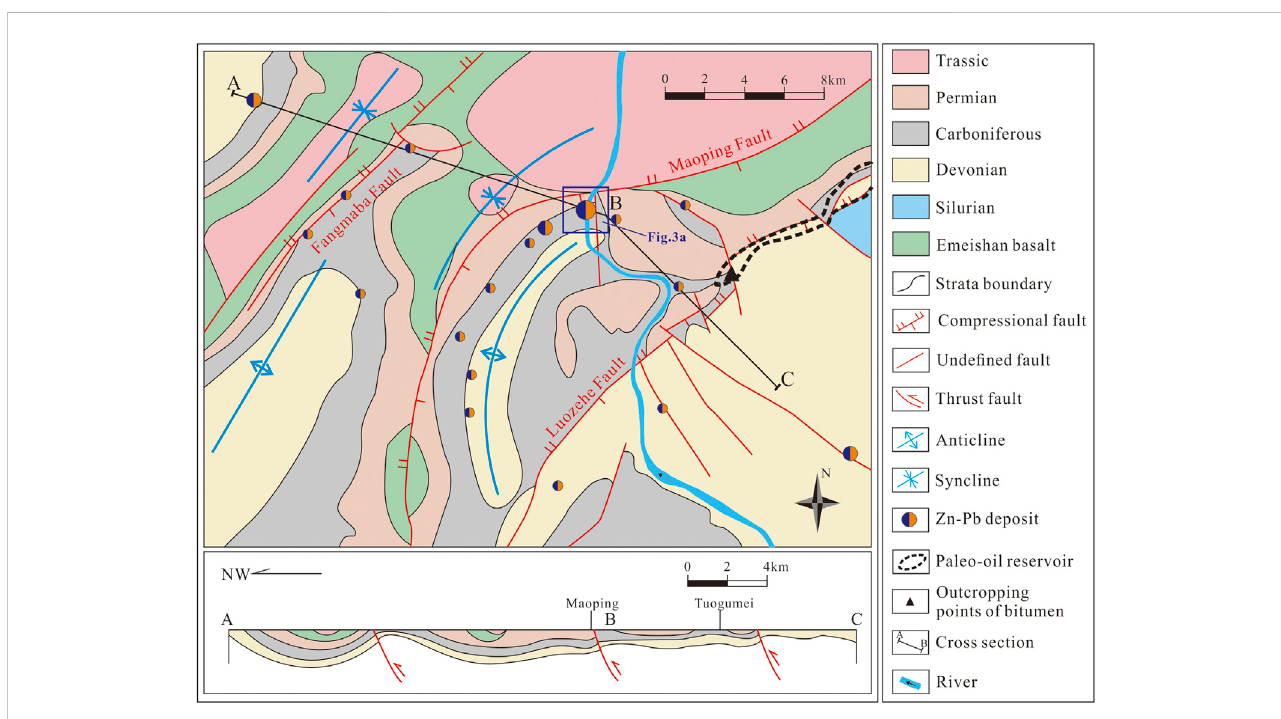
FIGURE 2 Geological map of the Maoping district showing the stratigraphy, structure and distribution of Pb – Zn deposits (modi fi ed after Liu and Lin, 1999).